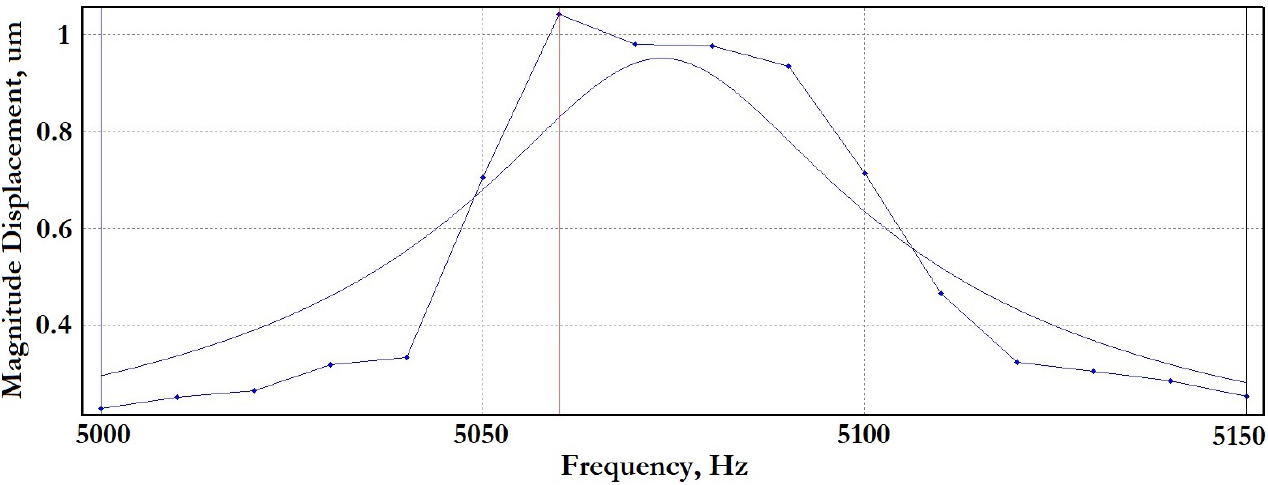
Figure 33. The measured amplitude–frequency response of the MEMS gyroscope in the DM.